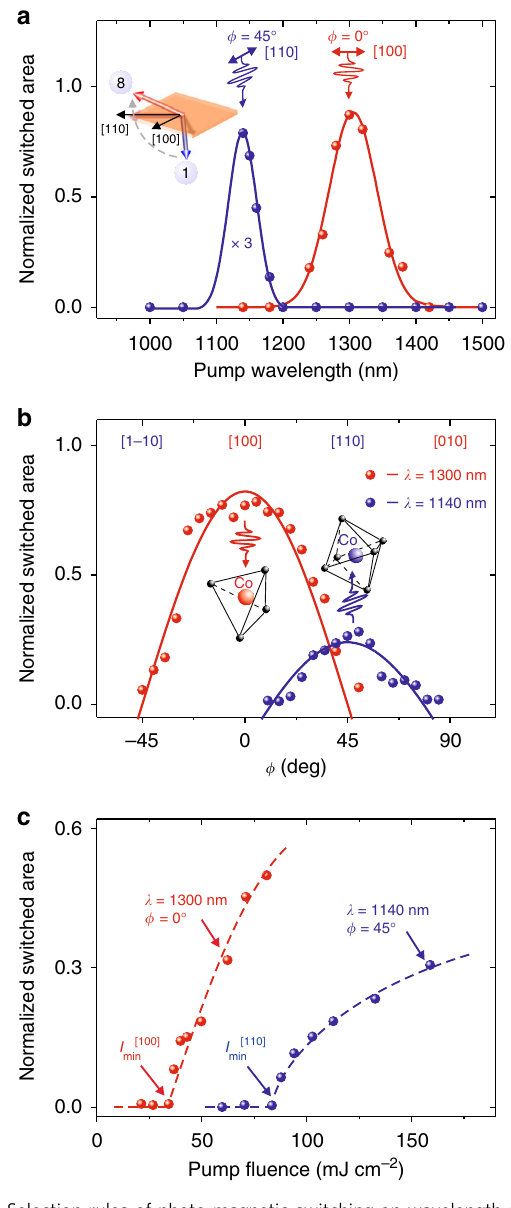
Fig. 4 Selection rules of photo-magnetic switching on wavelength and polarization. For measurements 5 laser pump pulses ( N = 5) were used. a Normalized switched area as a function of the photon energy for two polarizations E || [110] ( ϕ = 45°) and E || [100] ( ϕ = 0°). Solid lines were fi tted by Gaussian function. b Normalized switched area as a function of the angle ϕ for the incoming polarization for two photon energies 0.95 eV ( λ = 1300 nm) and 1.1 eV ( λ = 1140 nm). Solid lines are guides to the eye. c Fluence dependence of the normalized switched area for two photon energies 0.95 eV and 1.1 eV. Dashed lines are guides to the eye.